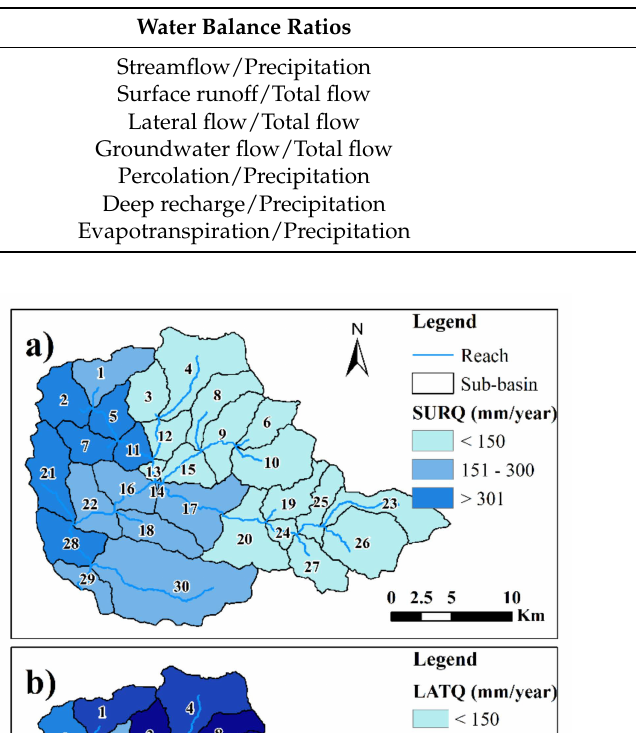
Table 5. Water balance ratios simulated by SWAT between 1982 and 2013 with current land use of the Uberaba River basin.